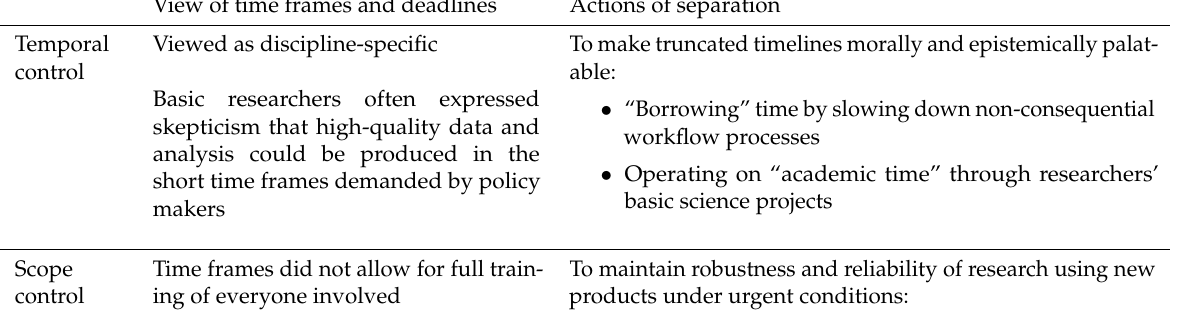
Table 1: Mechanisms for performed separation View of time frames and